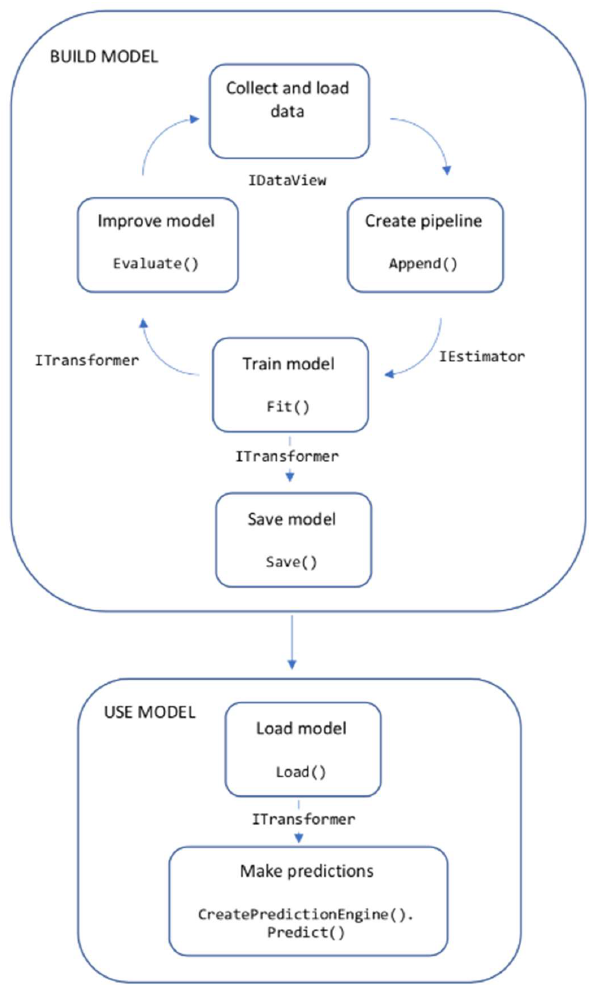
Figure 4. Diagram of the ML.NET code workflow [9]